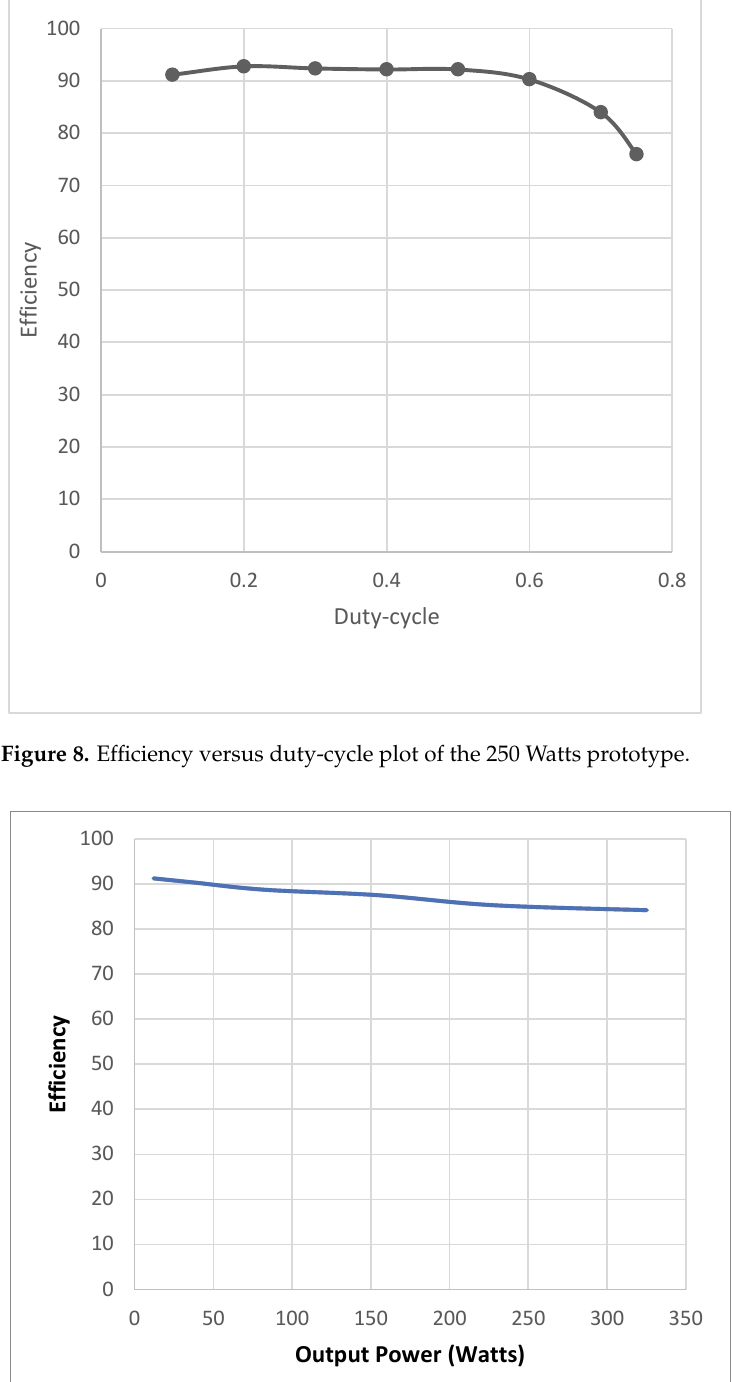
Figure 10. Efficiency comparison of the proposed and a cascaded boost converter. These prototypes were simulated using PSIM. The comparison presented in Figure 10 shows that the proposed converter is no less efficient than the cascaded converter, even